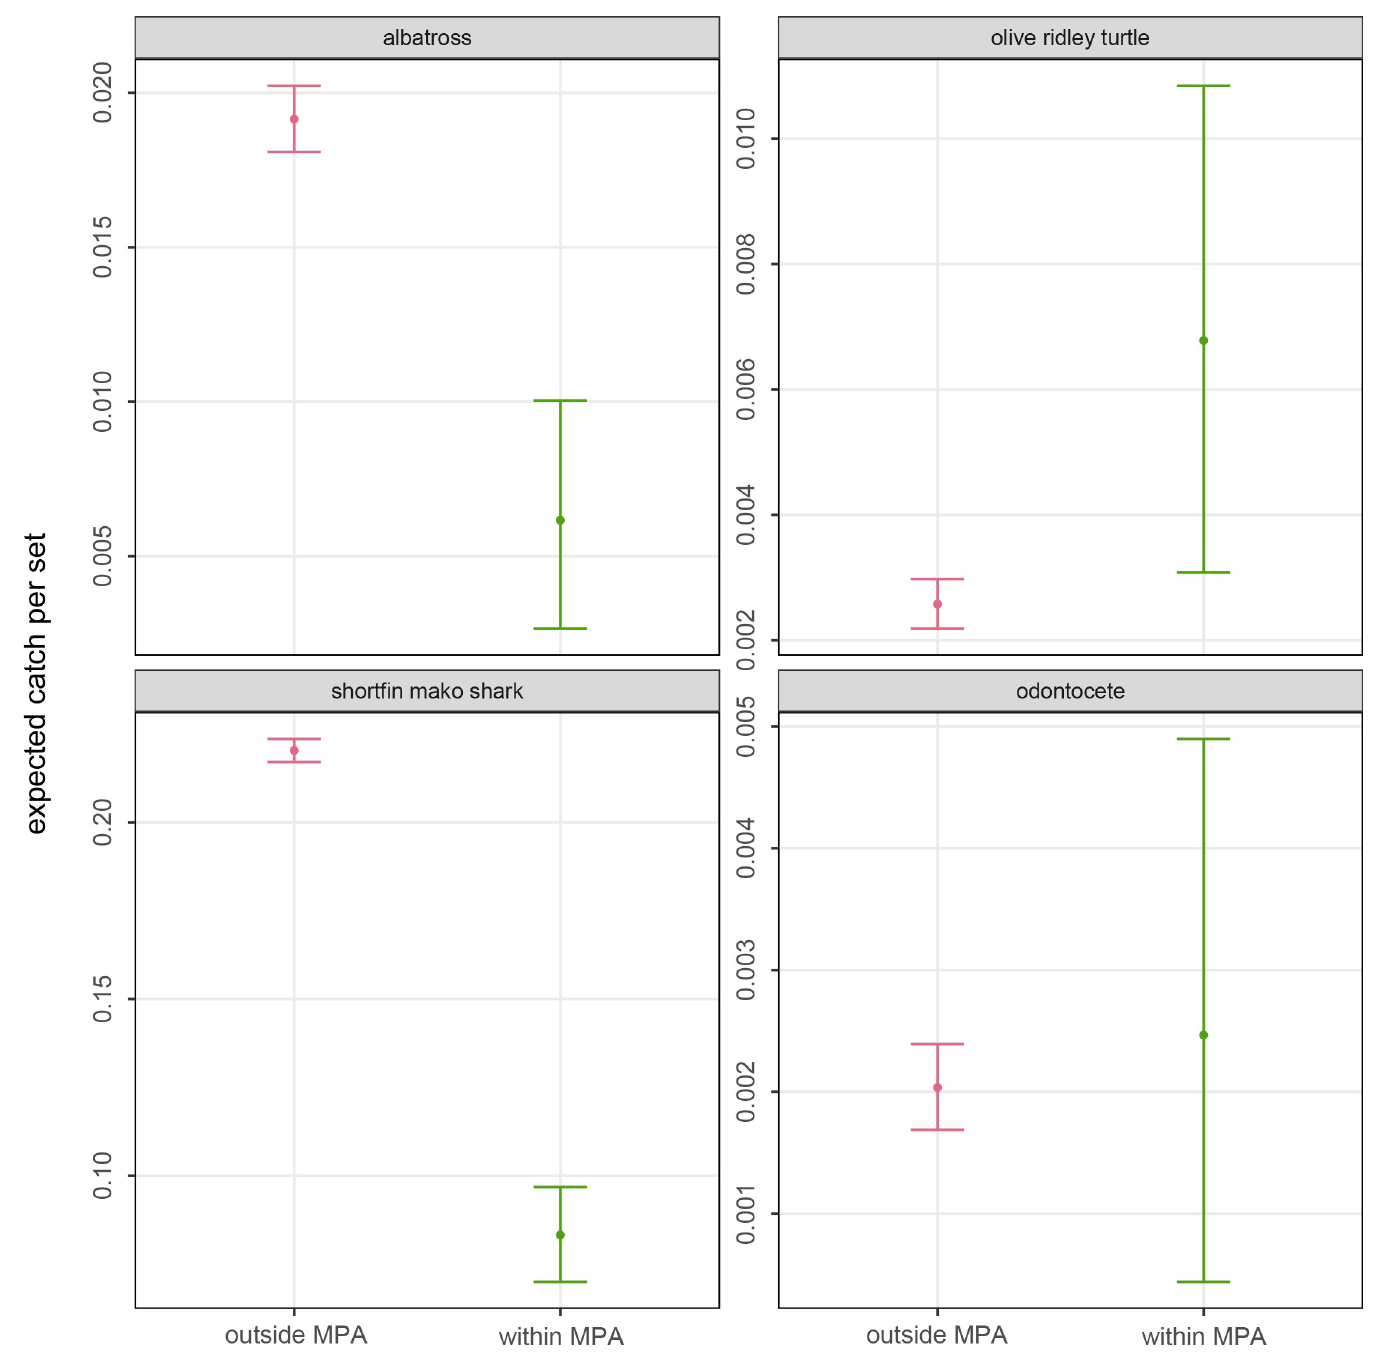
Fig 4. Comparison of the estimated mean catch rates inside and outside the combined MPAs (Kingman/Palmyra and Johnston) for 4 species of conservation concern with only limited catch data. These estimates were derived by sampling the summed catch and effort data from a species-specific binomial likelihood with a noninformative Bayes-Laplace prior. Solid dot shows the posterior mean rate and the vertical bar shows the 95% highest posterior density interval.